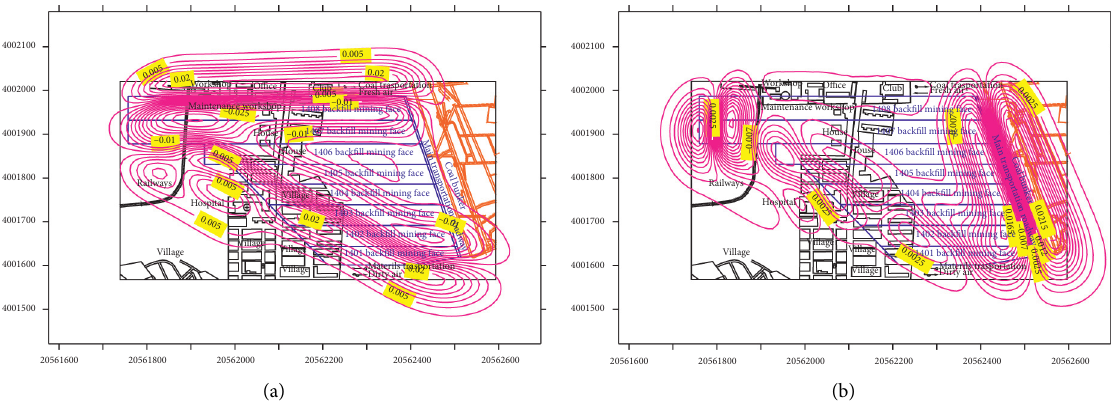
Figure 7: Contour map of surface curvature in RMCPB.